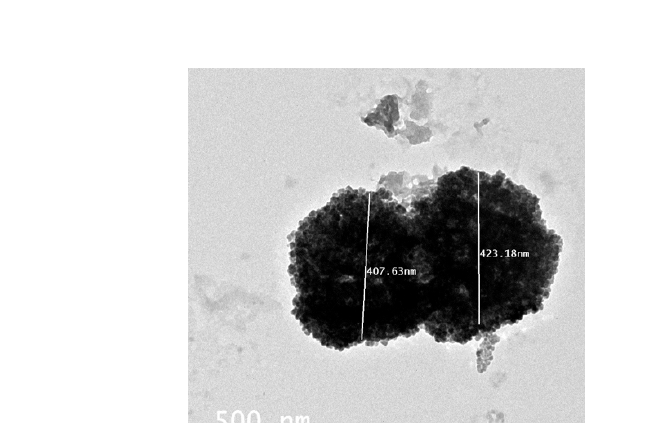
Table 4. Mean ± (SD) particle size (PS), entrapment efficiency (EE%) and zeta potential (ZP) of BA- loaded-LA-free-CL-NPs and BA-loaded-LA-modified-CL-NPs after 15-day storage at room temperature or 4 °C.